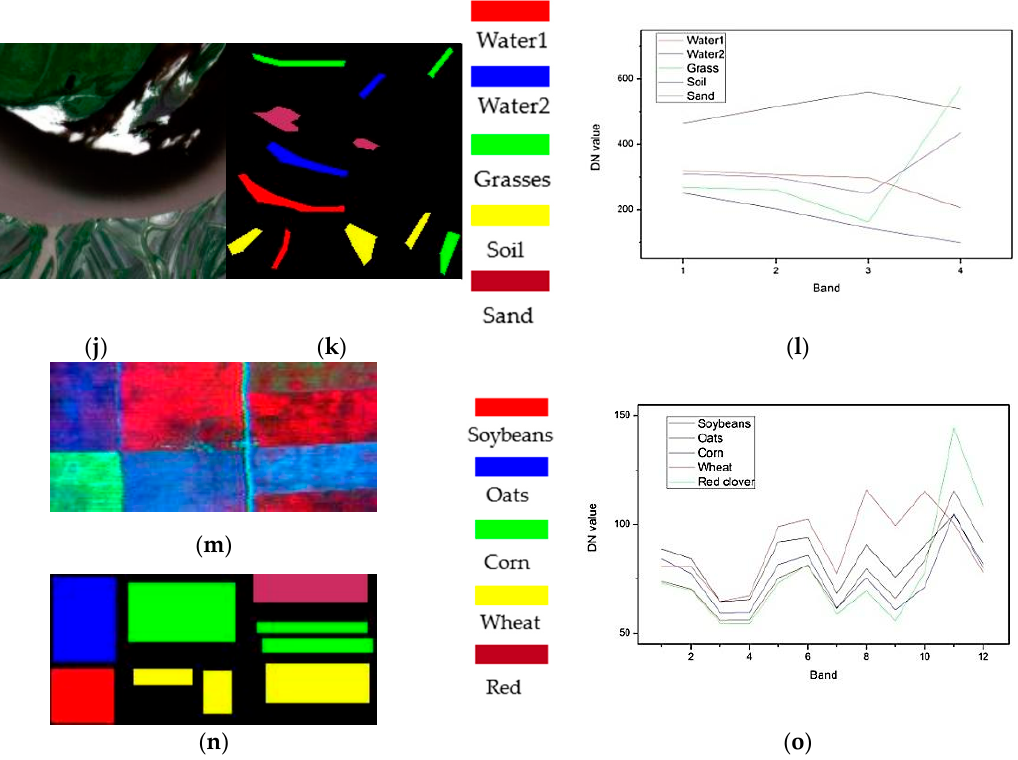
Figure 1. The multispectral images. ( a – c ) the true/false color map, the ground reference map and the corresponding spectral curves of ground truth classes of QuickBird datasets; ( d – f ) the corresponding maps of Landsat TM datasets; ( g – i ) the corresponding maps of Landsat ETM+ datasets; ( j – l ) the corresponding maps of GaoFen-1 datasets; ( m – o ) the corresponding maps of FLC1 datasets. ( a ) True color map; ( b ) false color map (7, 5, 3); ( c ) false color map (7, 5, 3); ( d ) true color map; and ( e ) false color map (bands 12, 9, and 1). Remote Sens. 2016 , 8 , x 10 of 23